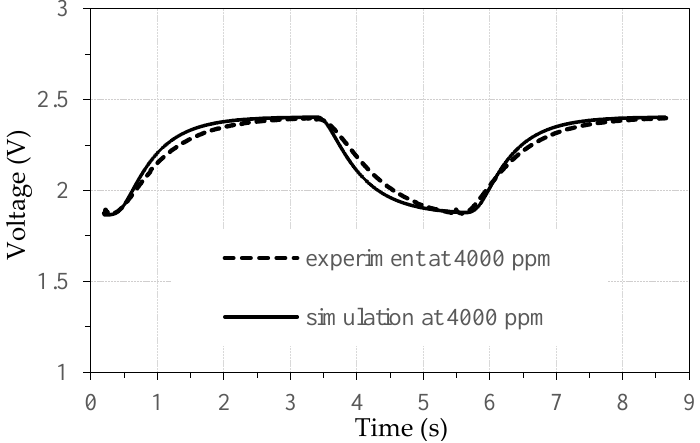
Table 2. Power and current values at different simulated temperatures.